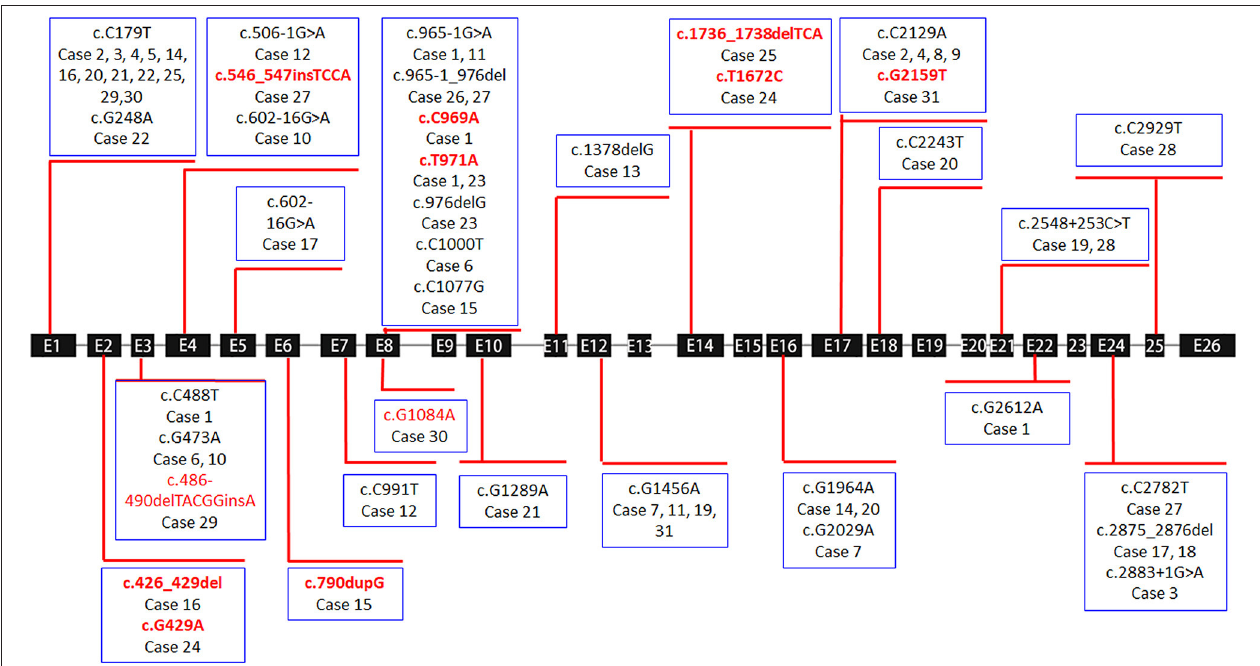
FIGURE 1 | Exon structure of the SLC12A3 gene with geometric shapes indicating the relative positions of different types of mutations. The 11 different types of novel mutations identified in this study are marked in red.